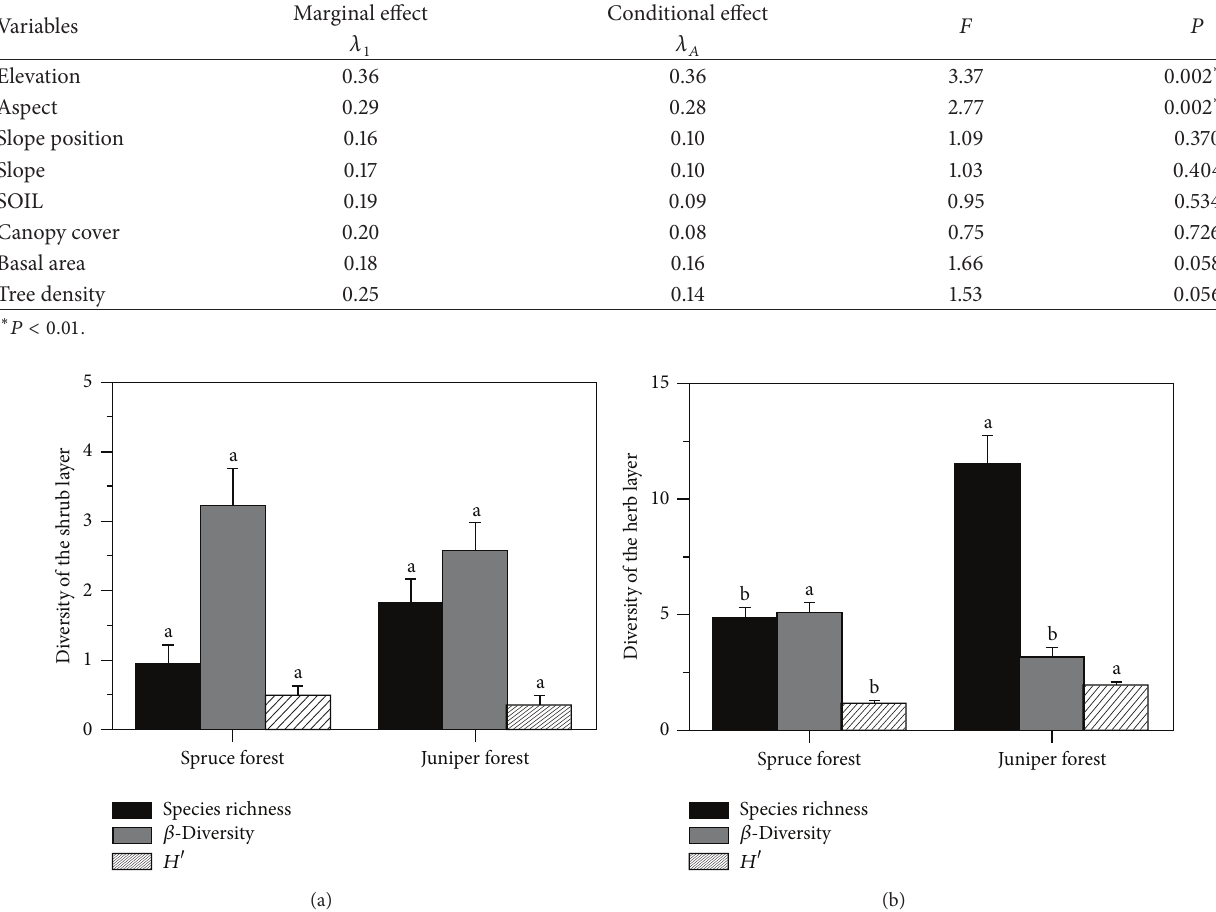
Figure 3: Comparison of species richness, 𝛼 - and 𝛽 -diversity of the shrub and herb layers of understory plant community between spruce and juniper